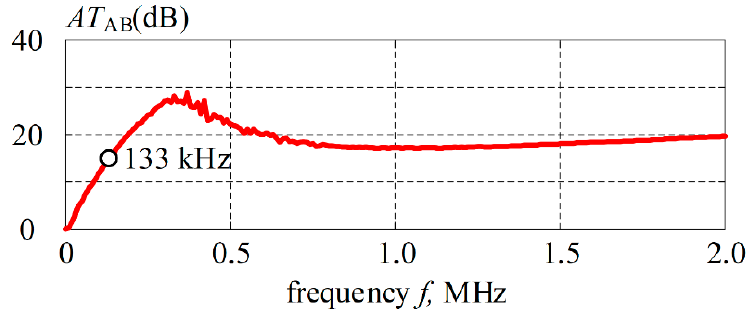
Figure 8. Insertion loss of the LC filter with two 33 μ H inductions.